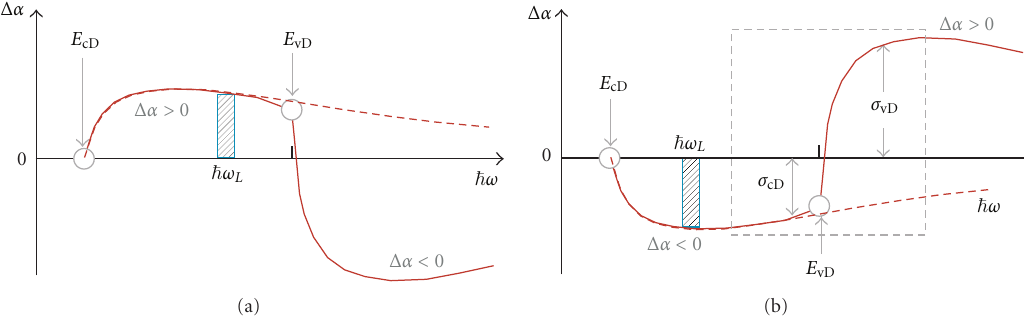
Figure 10: Schemes of photoinduced absorption (PIA) spectra Δ α ( ω ) for σ -DLSS (a) and γ -DLSS (b). Δ α ( ω ) give us energy position of DL concerning to both bands, defined from long-wave thresholds of an absorption ( E vD ) and the bleaching ( E cD )